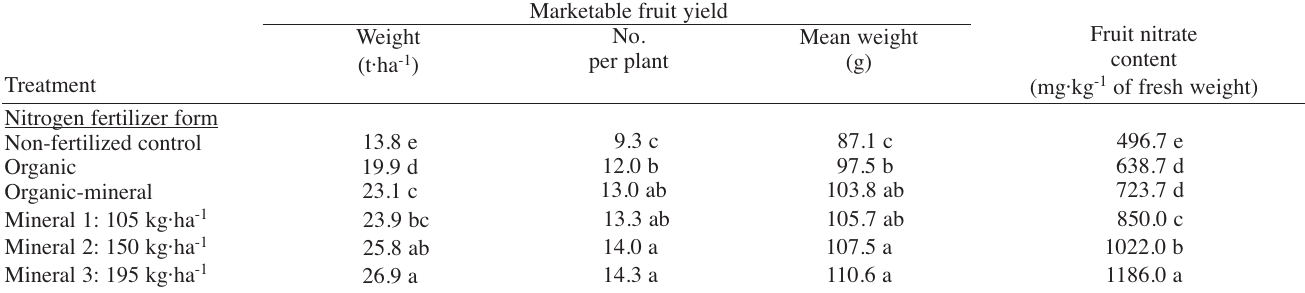
Table 6 - Zucchini under tunnel: yield results and fruit nitrate content in the autumn-winter cycle as a function of nitrogen fertilizer form. Fondi (Latina, Italy), 2003-2004